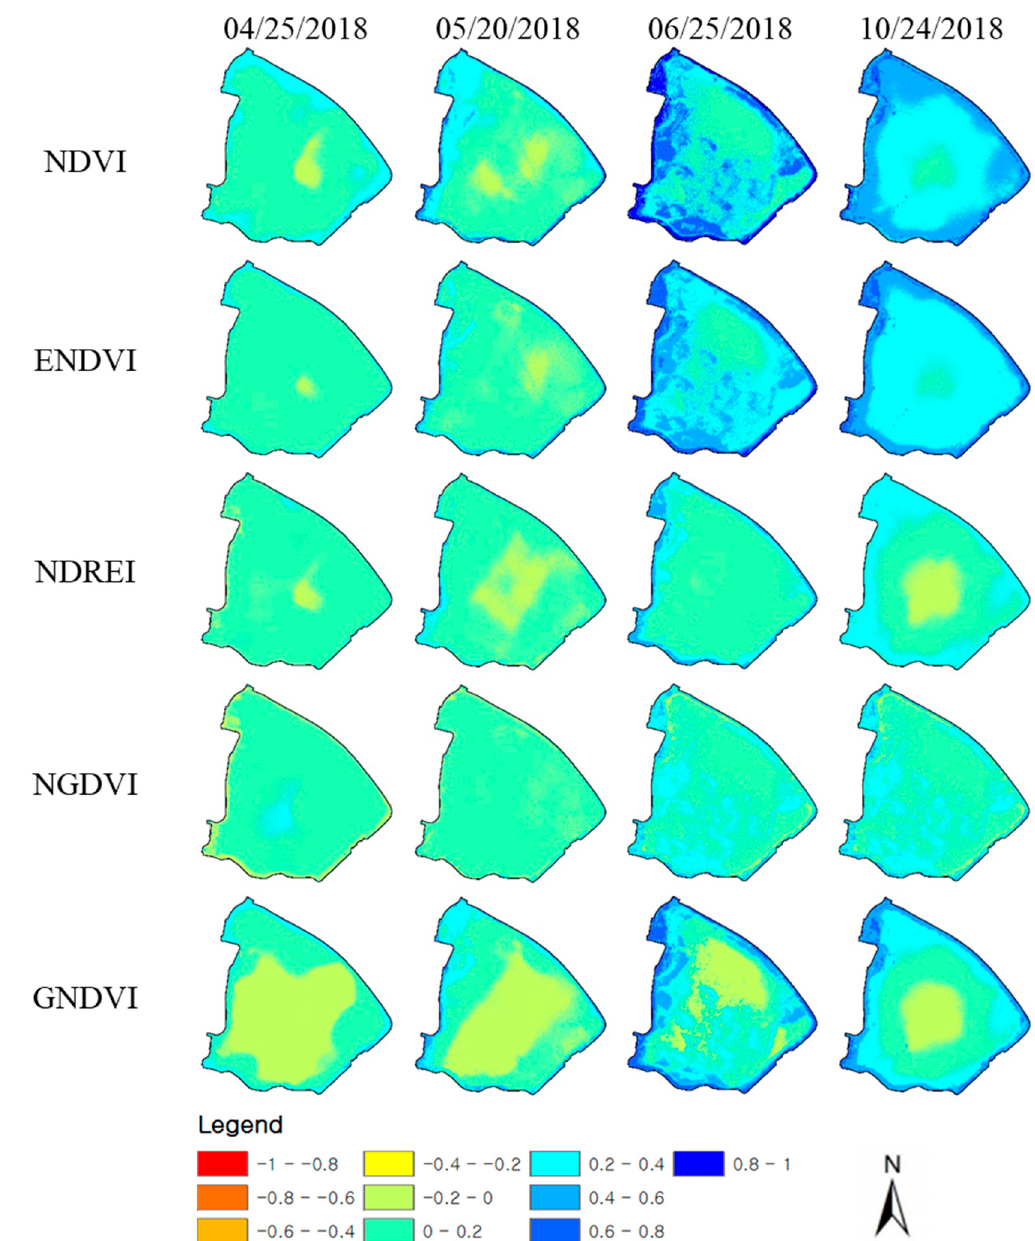
Figure 6. Analysis results of the vegetation indices.